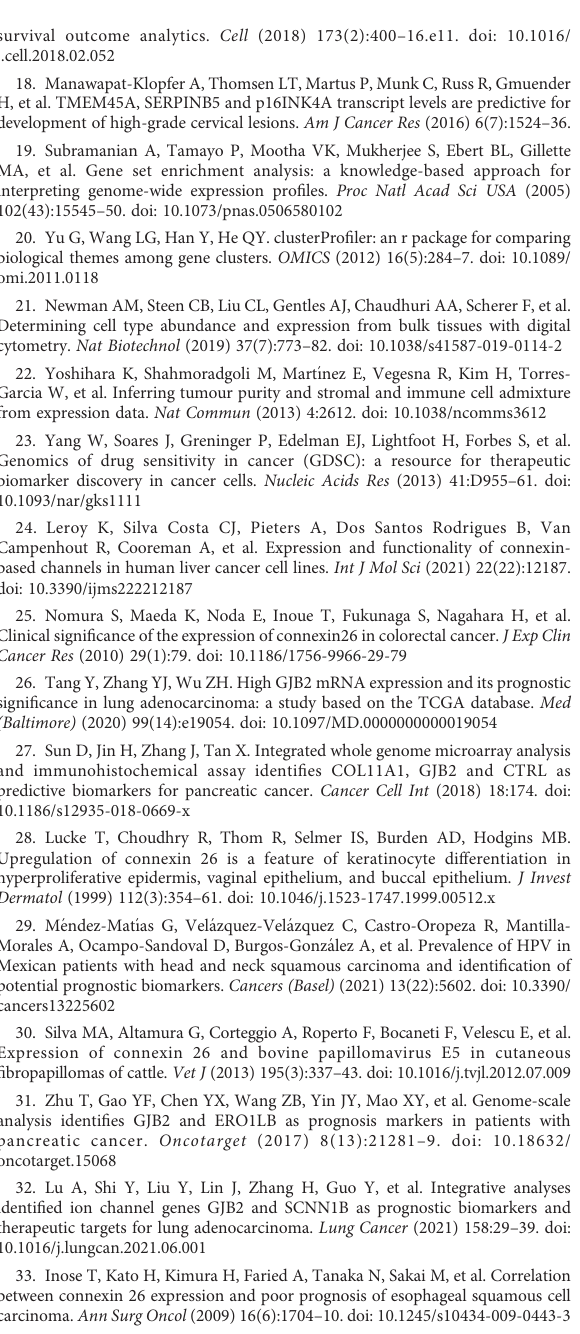
stage ≥ IIB.HPA:TheHumanProteinAtlas;FIGO:TheInternationalFederation of Gynecology and Obstetrics; SCC: Squamous cell carcinoma. *p < 0.05, ns: not signi fi cant. SUPPLEMENTARY FIGURE 2 Gene ontology analysis of the top 500 genes co-expressed with GJB2.